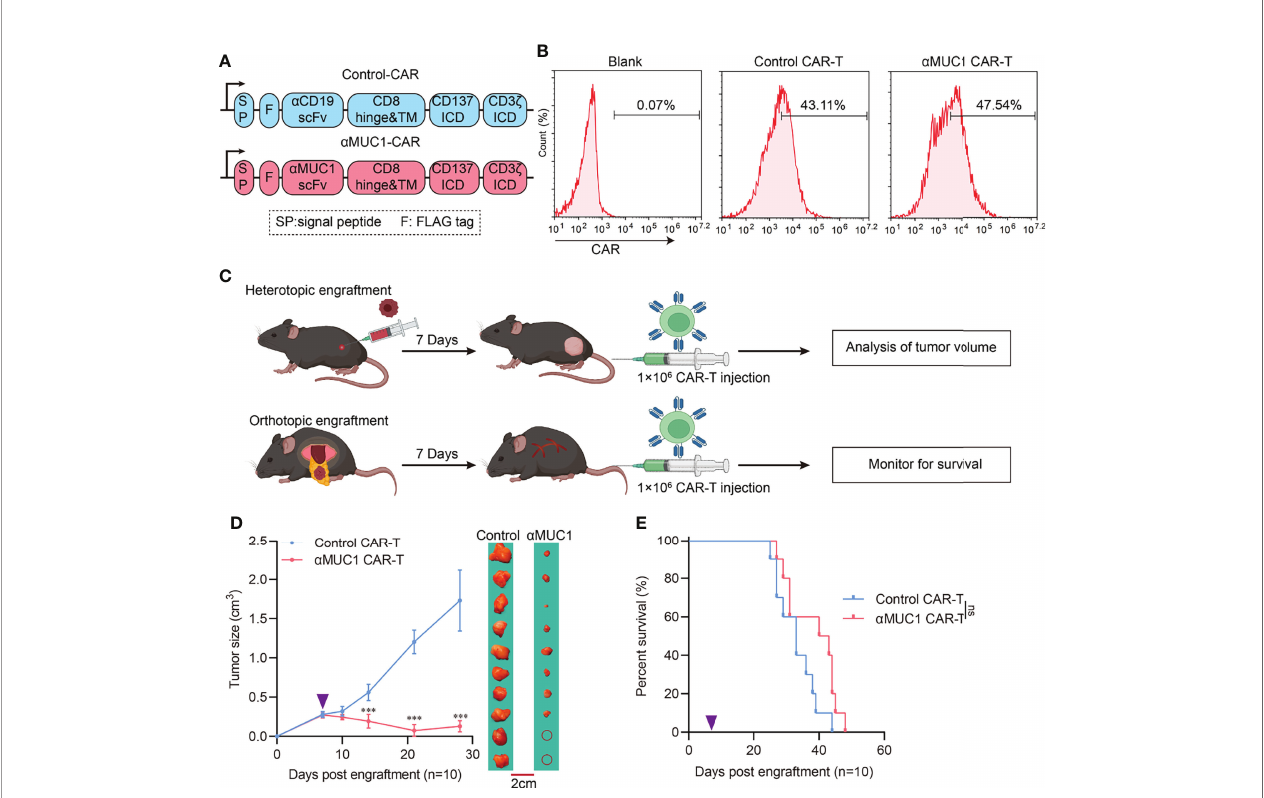
FIGURE 4 | Response of heterotopic or orthotopic engraftment tumor to a MUC1 CAR-T transfer. (A) Schematic diagram of CAR structure, VH and VL domains of scFv are joined by a (G 4 S) 3 linker. Anti-CD19-CAR was used as control. (B) Flow cytometry assay of transfection ef fi ciency of CAR-T cells. (C) Schematic outline of experimental approaches and analyses. (D) Heterotopic tumor size after 1×10 6 a MUC1 CAR-T transfer. The purple arrows indicate CAR-T cells administration (n=10 each, compared with Control CAR-T group, ***P<0.001). (E) Survival of orthotopic tumor recipients after 1×10 6 a MUC1 CAR-T transfer. The purple arrows indicate CAR-T cells administration (n=10 each, compared with Control CAR-T